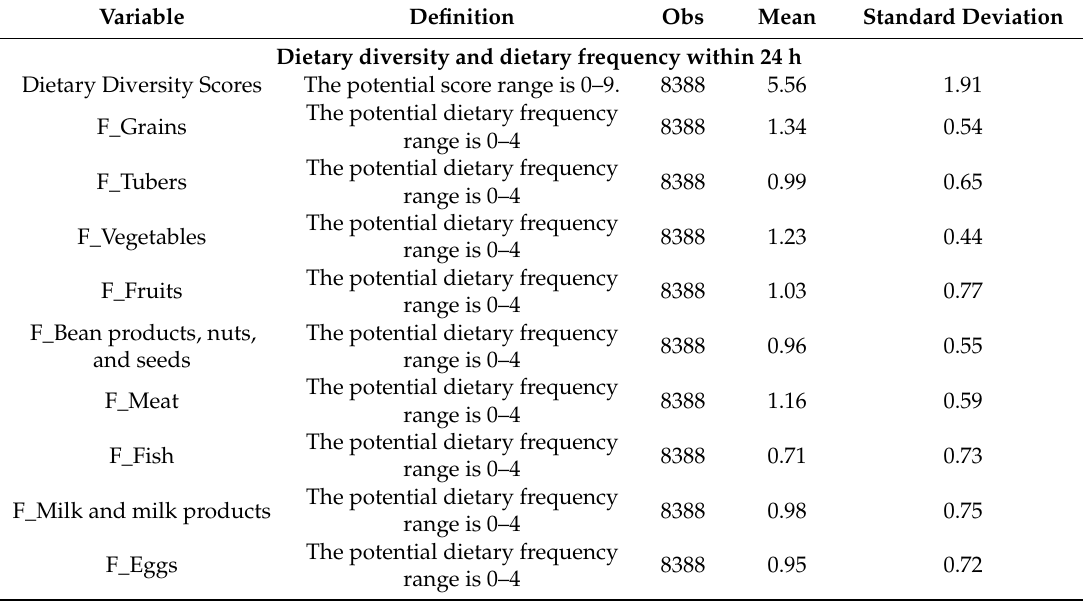
Table 3. Summary statistics of dietary diversity and dietary frequency within 24